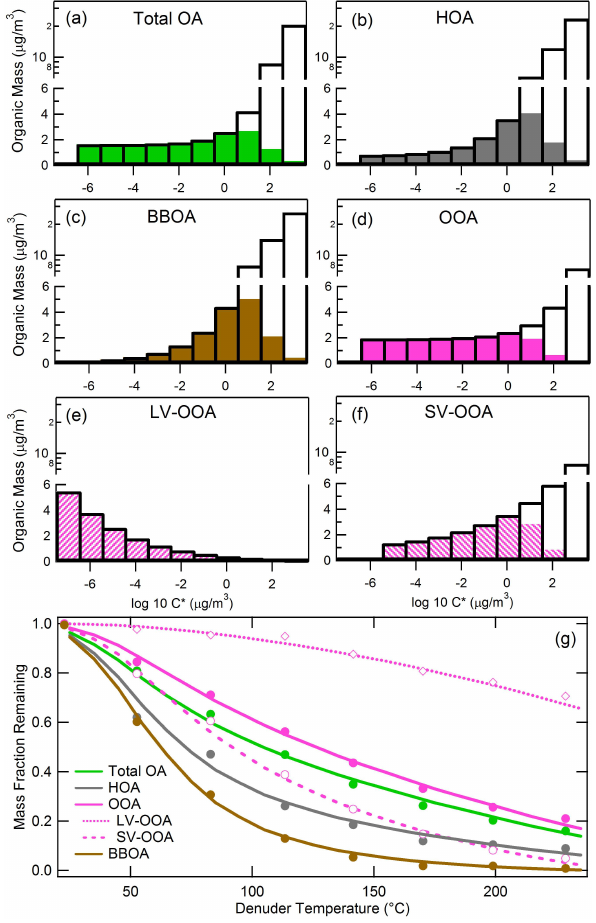
Fig. 5. Volatility distributions derived for the MILAGRO cam- paign average OA, HOA, BBOA and OOA (including LV-OOA and SV-OOA) factors are shown along with the calculated (assuming 1H vap =100kJ/mol) and observed mass